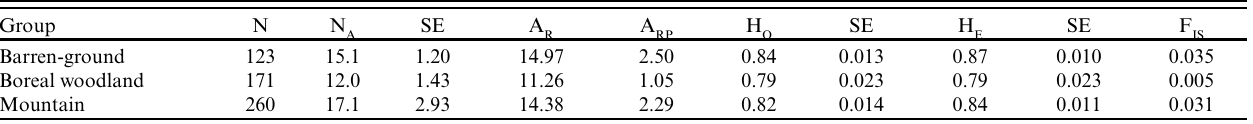
Table 1 . Genetic diversity estimates, averaged across nine microsatellite loci, for the three major caribou ( Rangifer tarandus ) groups identified by structure analysis: number of samples (N), number of alleles (NA), allelic richness (AR), private allelic richness (ARP), observed (HO) and expected (HE) heterozygosity, FIS estimates, and standard errors (SE) for each estimate. Group N N SE A A H SE H SE F A R RP O E IS Barren-ground 123 15.1 1.20 14.97 171